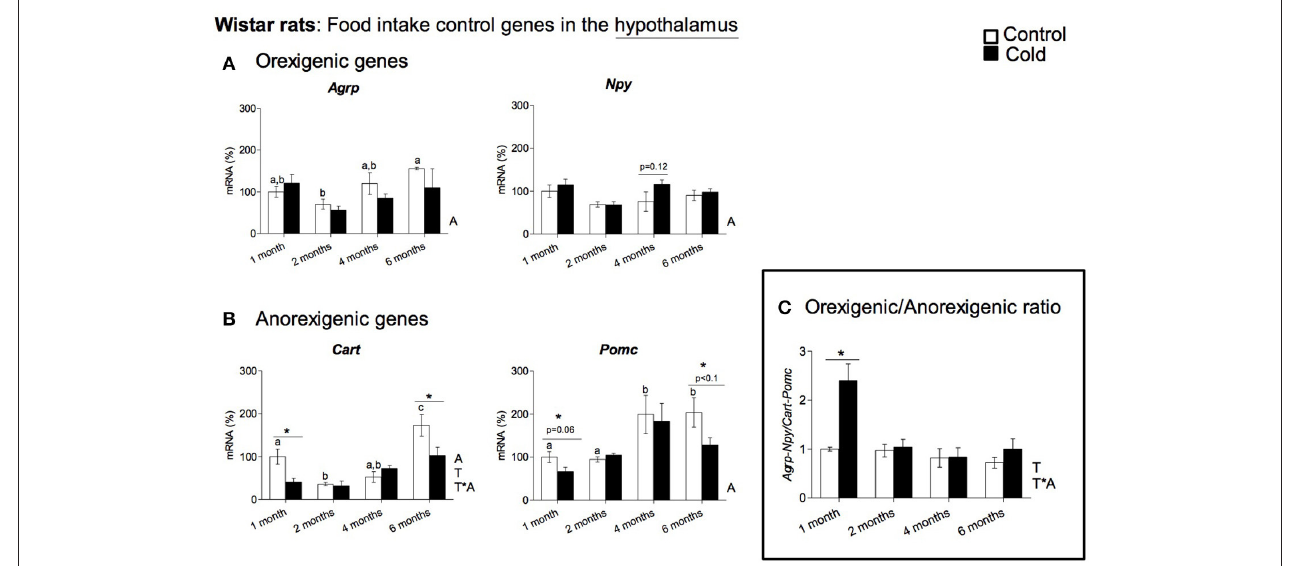
FIGURE 1 | Gene expression of (A) orexigenic ( Agrp and Npy ) and (B) anorexigenic ( Cart and Pomc ) related genes measured by qRT-PCR in the hypothalamus of rats of different ages (from 1 to 6 months) housed at different room temperatures: 22 ◦ C (control) or 4 ◦ C for 1 week (cold). Results represent mean ± SEM ( n = 5–6) of ratios of specific mRNA levels relative to Gdi, expressed as a percentage, where the 1-month control group was set as 100%. The orexigenic/anorexigenic ratio (C) was calculated as the sum of the expression of the orexigenic peptide ( Agrp and Npy ) genes divided by the sum of the expression of the orexigenic peptide ( Cart and Pomc ) genes. Bars not sharing common letters (a,b,c) are significantly different (one-way ANOVA, p < 0.05). DMS post-hoc was used after one-way ANOVA analysis. *Effect of cold exposure (cold-exposed rats vs. their respective controls; Student’s t- test, p < 0.05, or indicated when different). Two-way ANOVA ( p < 0.05) was performed for cold and control conditions (T) and age (A). For this statistical analysis: T indicates effect of temperature, A effect of age, and T*A the interaction of temperature and